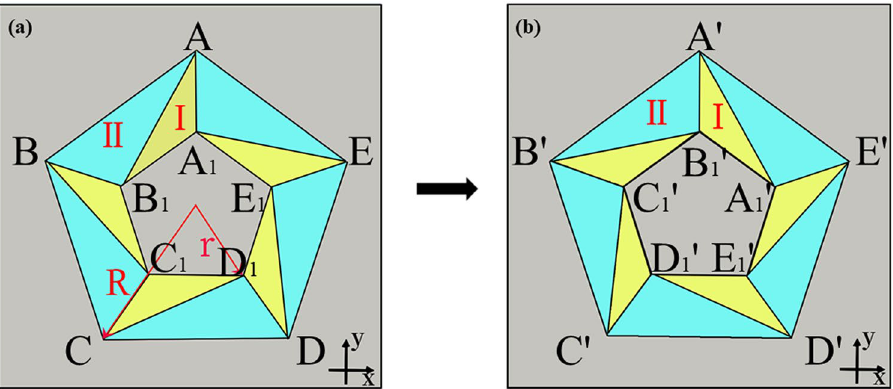
Figure 3. Schematic of coordinate transformation in the design of acoustic rotator. ( a ) Virtual space, R and r mean the radii of outer and inner pentagons respectively. ( b ) Physical